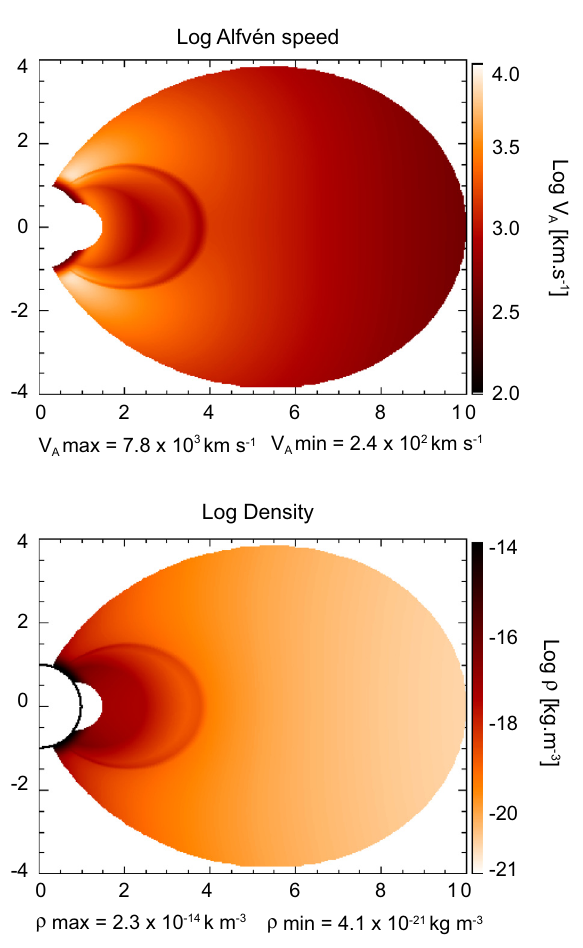
Fig. 10. Alfvén speed (top) and plasma density (bottom) profiles for the noon meridian plane (Sun to the right) used in the 2D MHD simulation for 11 June 2001. X - and y -axes are in units of R E . The inner boundary is a realistic ionosphere and the outer boundary is at 10 R E